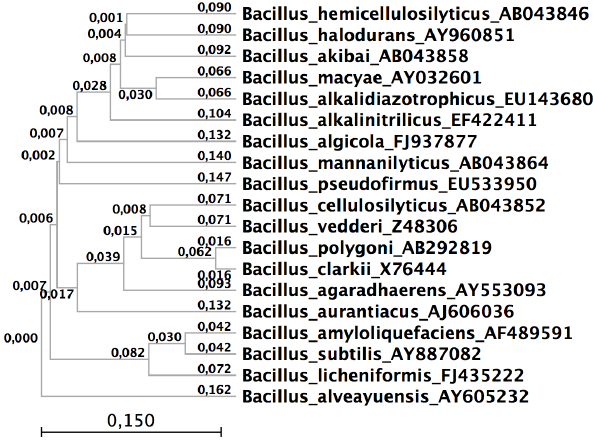
Figure 1. Phylogenetic tree highlighting the position of Bacillus cellulosilyticus N-4 DSM 2522 within the Bacillales . The strains and their corresponding NCBI accession numbers: Bacillus hemicellulosilyti- cus DSM 16731 T AB043846; Bacillus halodurans XJU-2 AY960851; Bacillus akibai ATCC 43226 T AB043858; Bacillus macyae DSM 16346 T AY032601; Bacillus alkalidiazotrophicus UNIQEM U377 T EU143680; Bacillus alkalinitrilicus UNIQEM U240 T EF422411; Bacillus algicola LS7 FJ937877; Bacillus mannanilyticus DSM 16130 T AB043864; Bacillus pseudofirmus SVB1 EU533950; Bacillus cellulosilyticus DSM 2522 T AB043852; Bacillus vedderi DSM 9768 T Z48306; Bacillus polygoni JCM 14604 T AB292819; Bacillus clarkia DSM 8720 T X76444; Bacillus agaradhaerens GSP78 AY553093; Bacillus aurantiacus B1-1 AJ606036; Bacillus amyloliquefaciens CMB01 AF489591; Bacillus subtilis AY887082; Bacillus licheniformis 11 FJ435222; and Bacillus alveayuensis KCTC 10634 T AY605232.